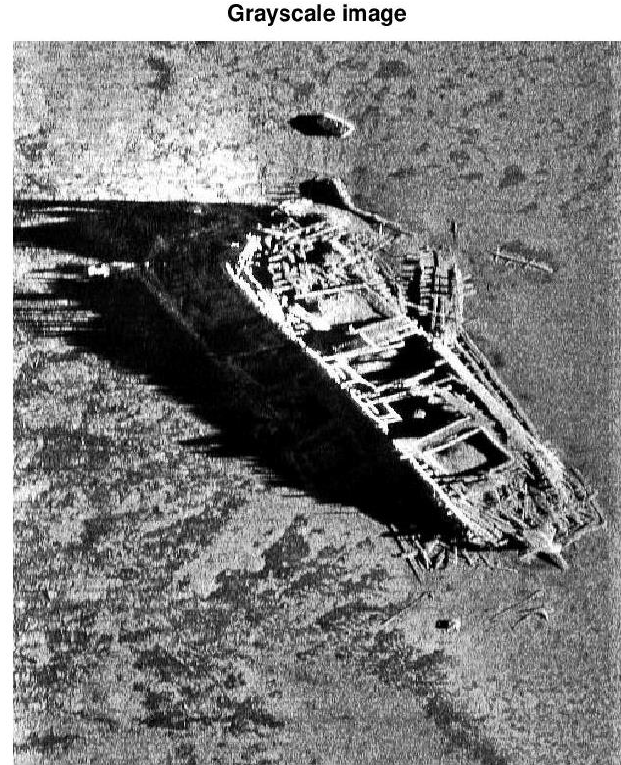
Figure 2. Test image Klein (grayscale).